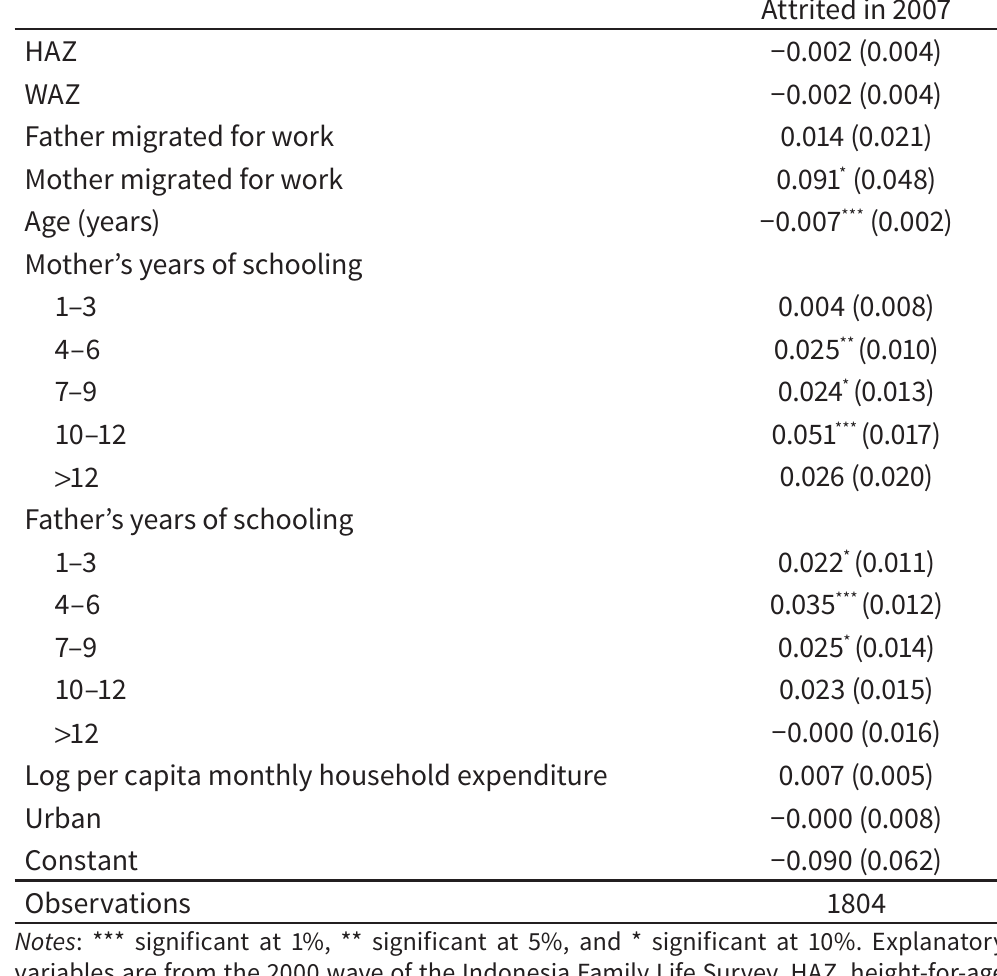
Selective attrition